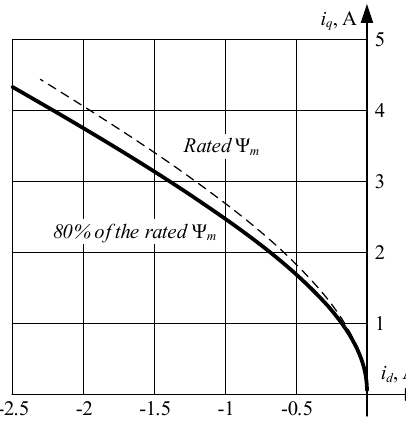
Figure 4. MTPA trajectories in i d i q plane at different flux-linkages.